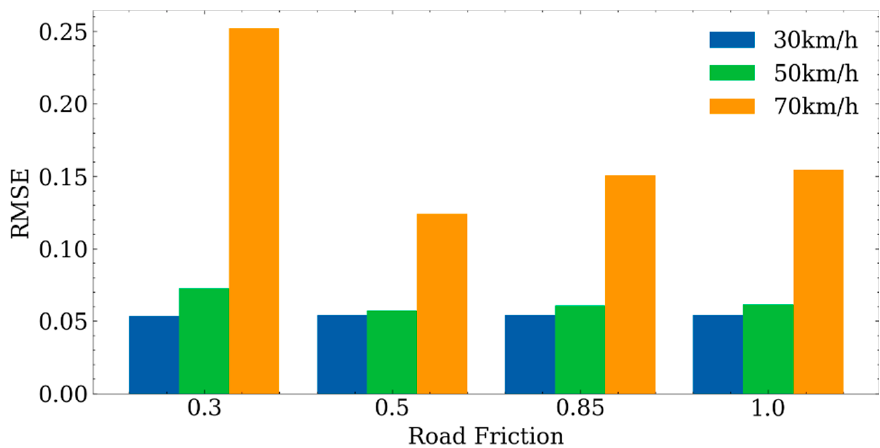
Figure 9. RMSE of the prediction vs. the reference.